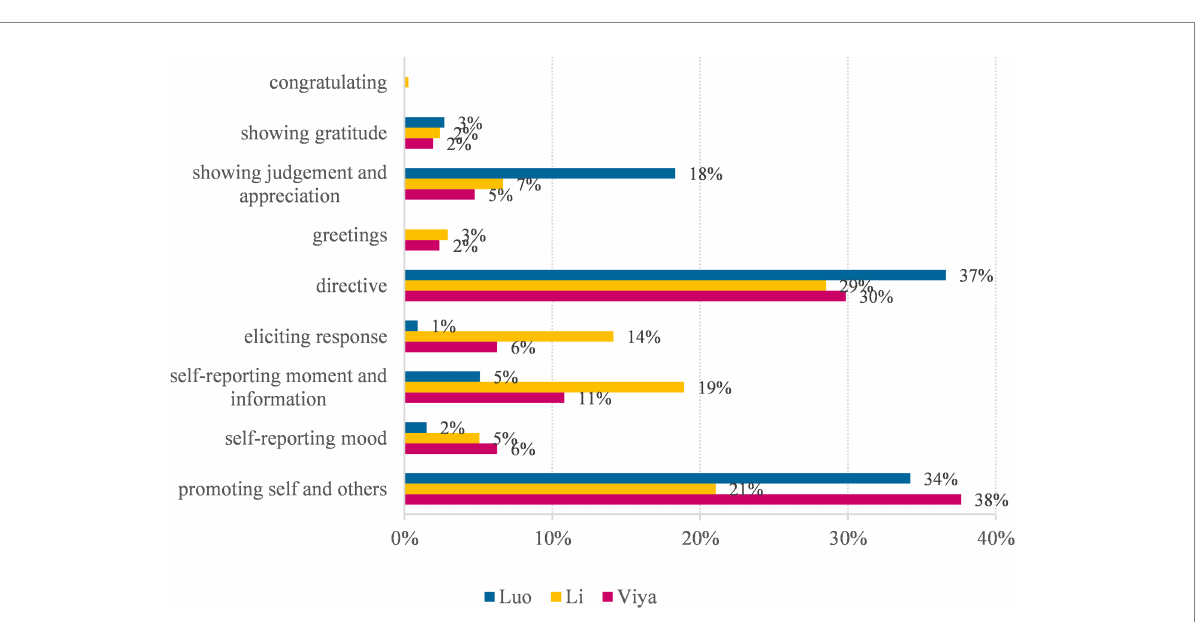
FIGURE 2 Distribution of speech acts among